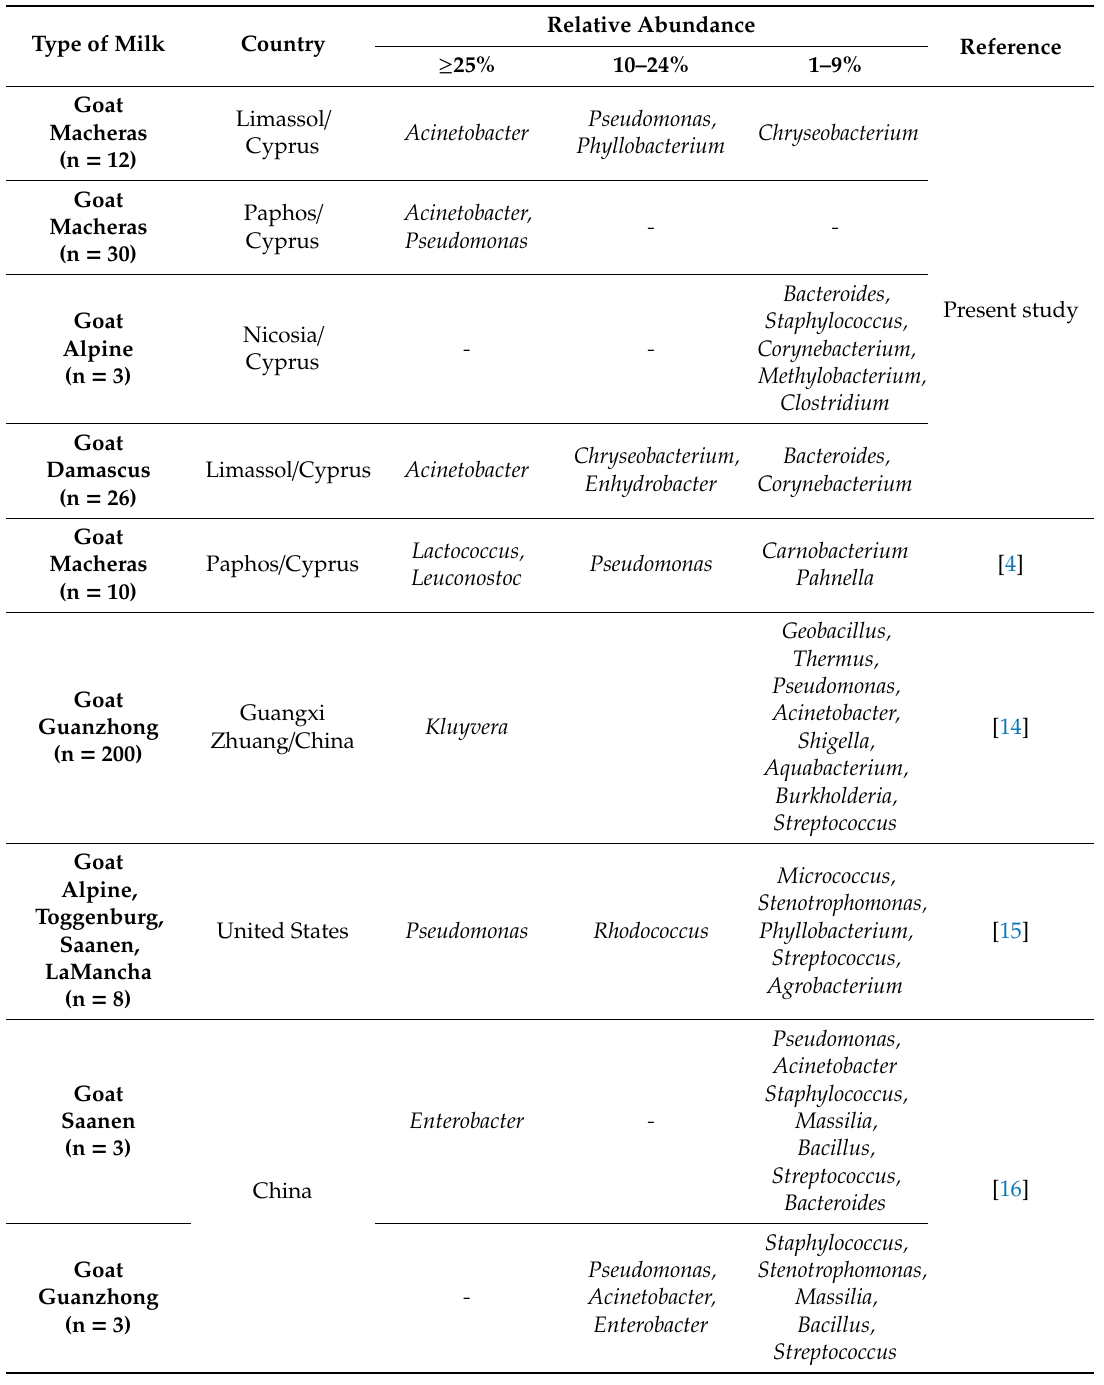
Table 3. The relative abundance of bacterial genera in goat milk based on 16S rRNA gene metagenomic